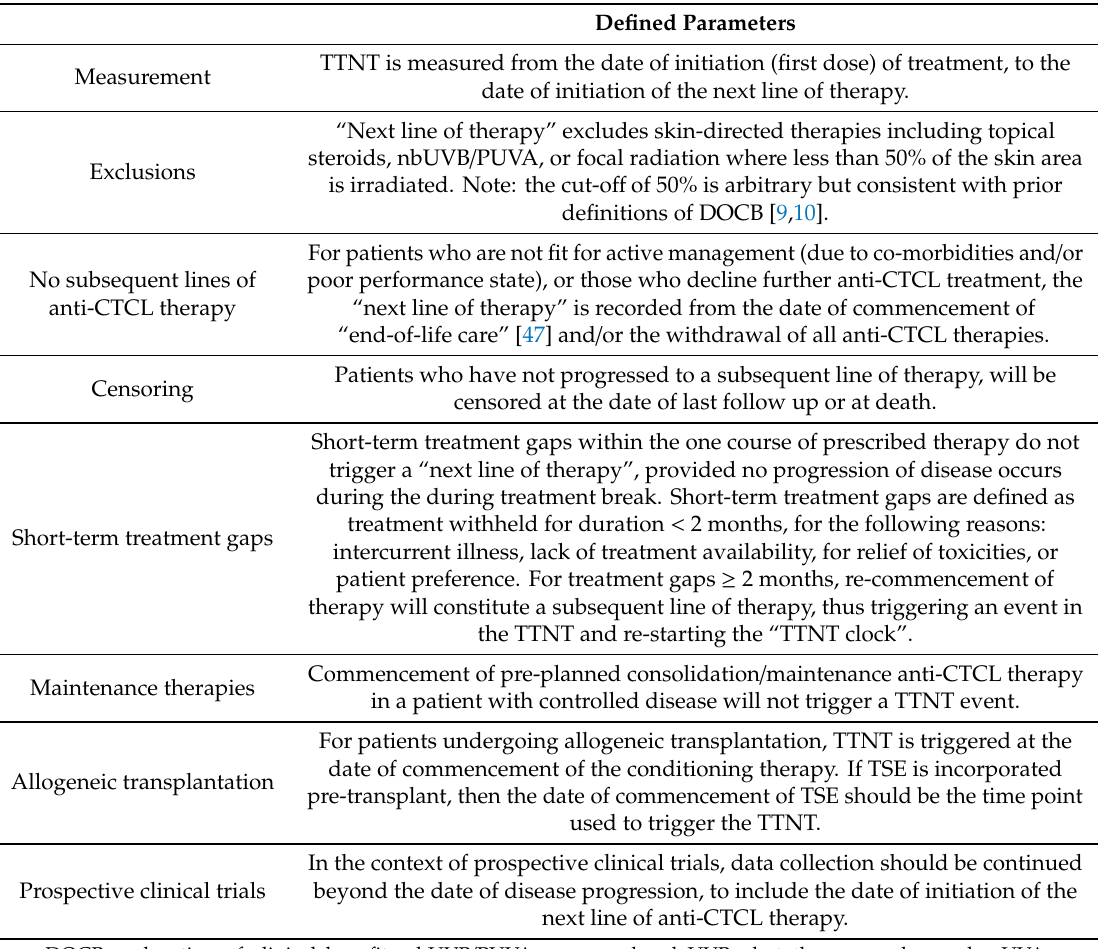
Table 2. Proposed standardisation of the definition of time to next treatment (TTNT) for use in future clinical studies of primary cutaneous T-cell lymphomas